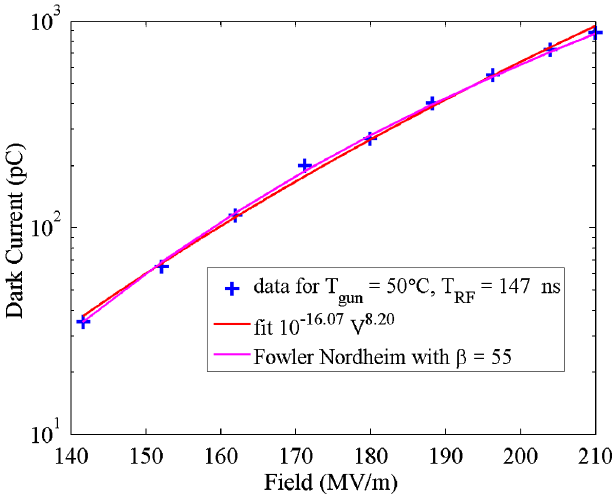
FIG. 12. Dark current as a function of gun temperature at two different SLED-II power levels with 147 ns